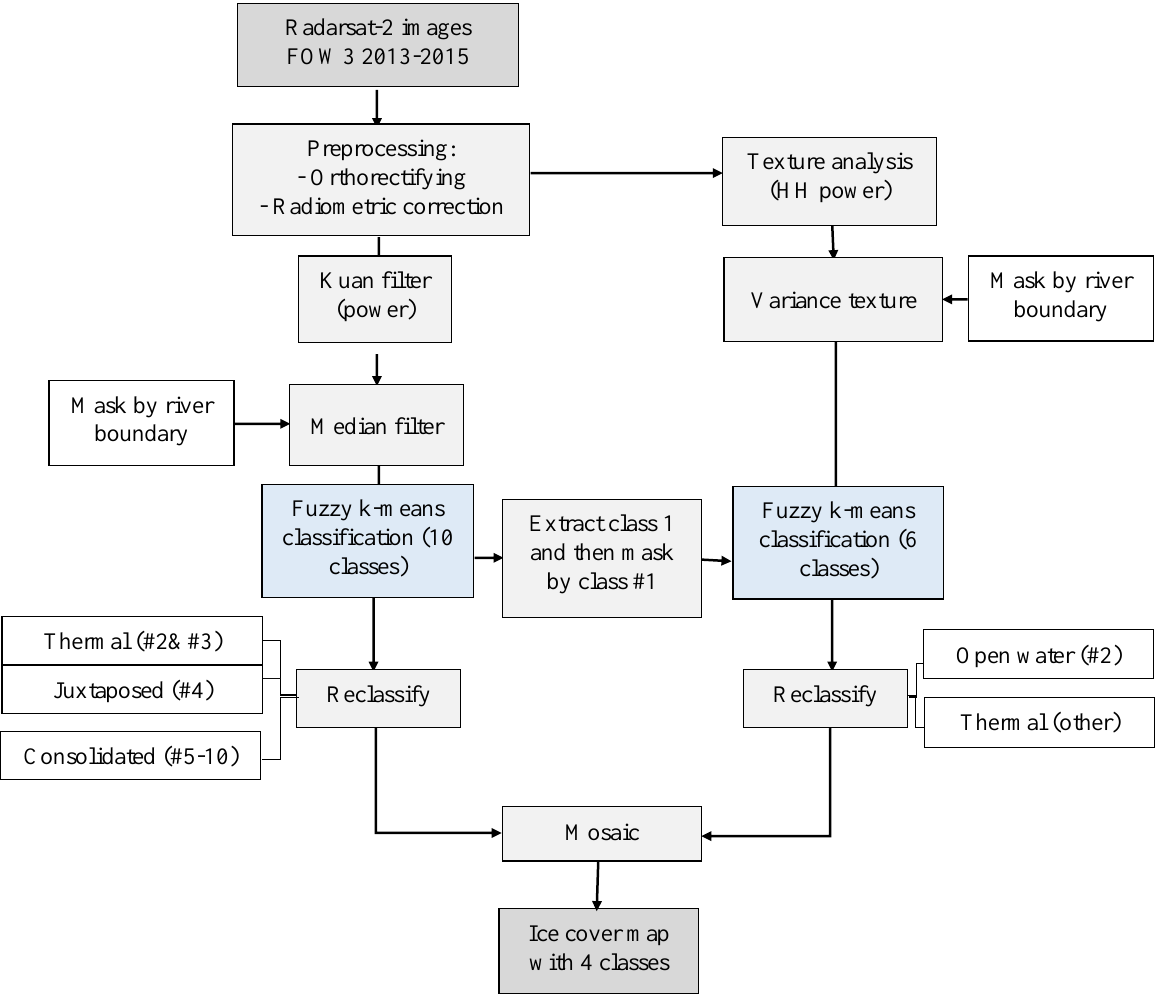
Figure 6. Processing steps for mapping river ice in Slave River from RADARSAT-2